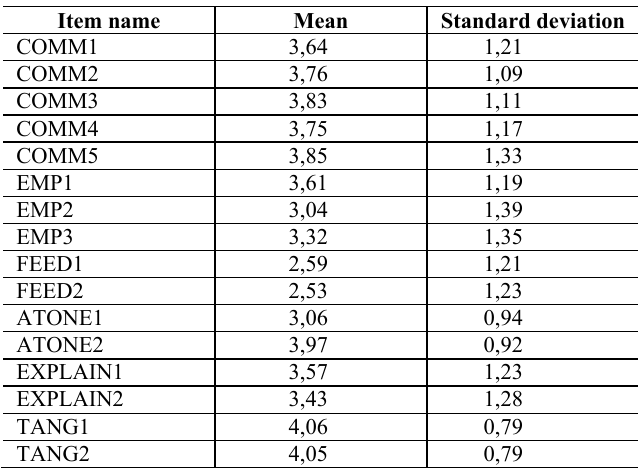
Table 2: A descriptive analysis of perceptual